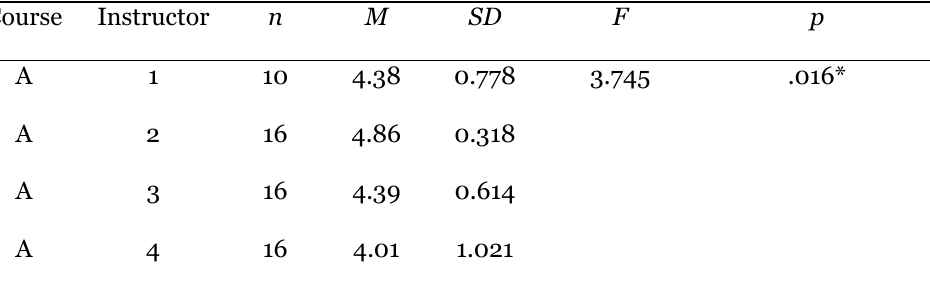
Descriptive Statistics of Facilitation of Discourse (FD) Scores as a Function of Instructor and Course